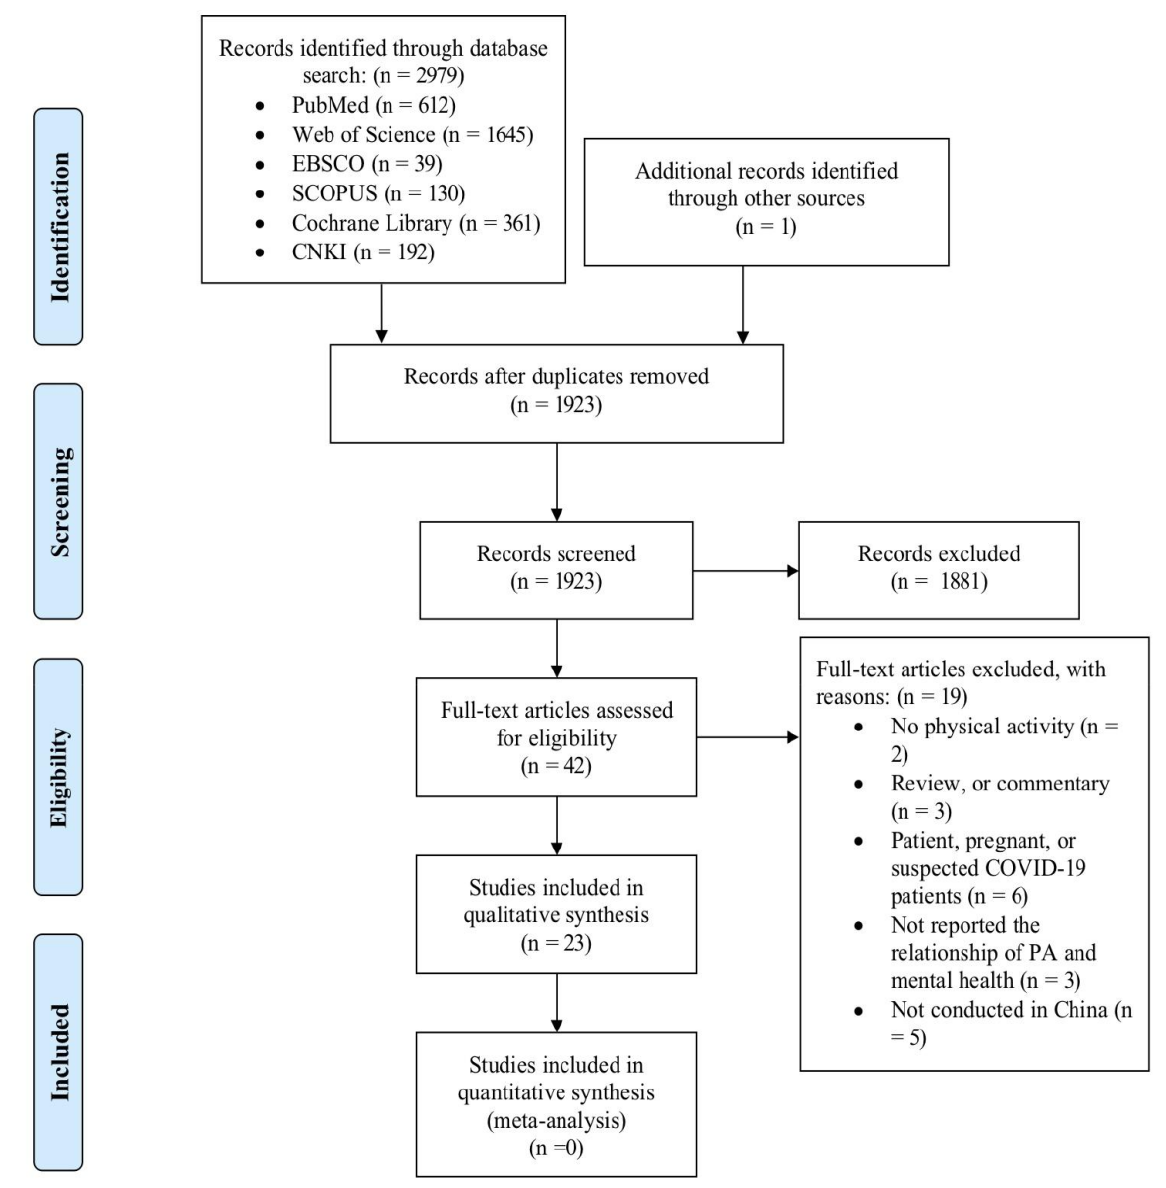
Figure 1. Study selection flow diagram.